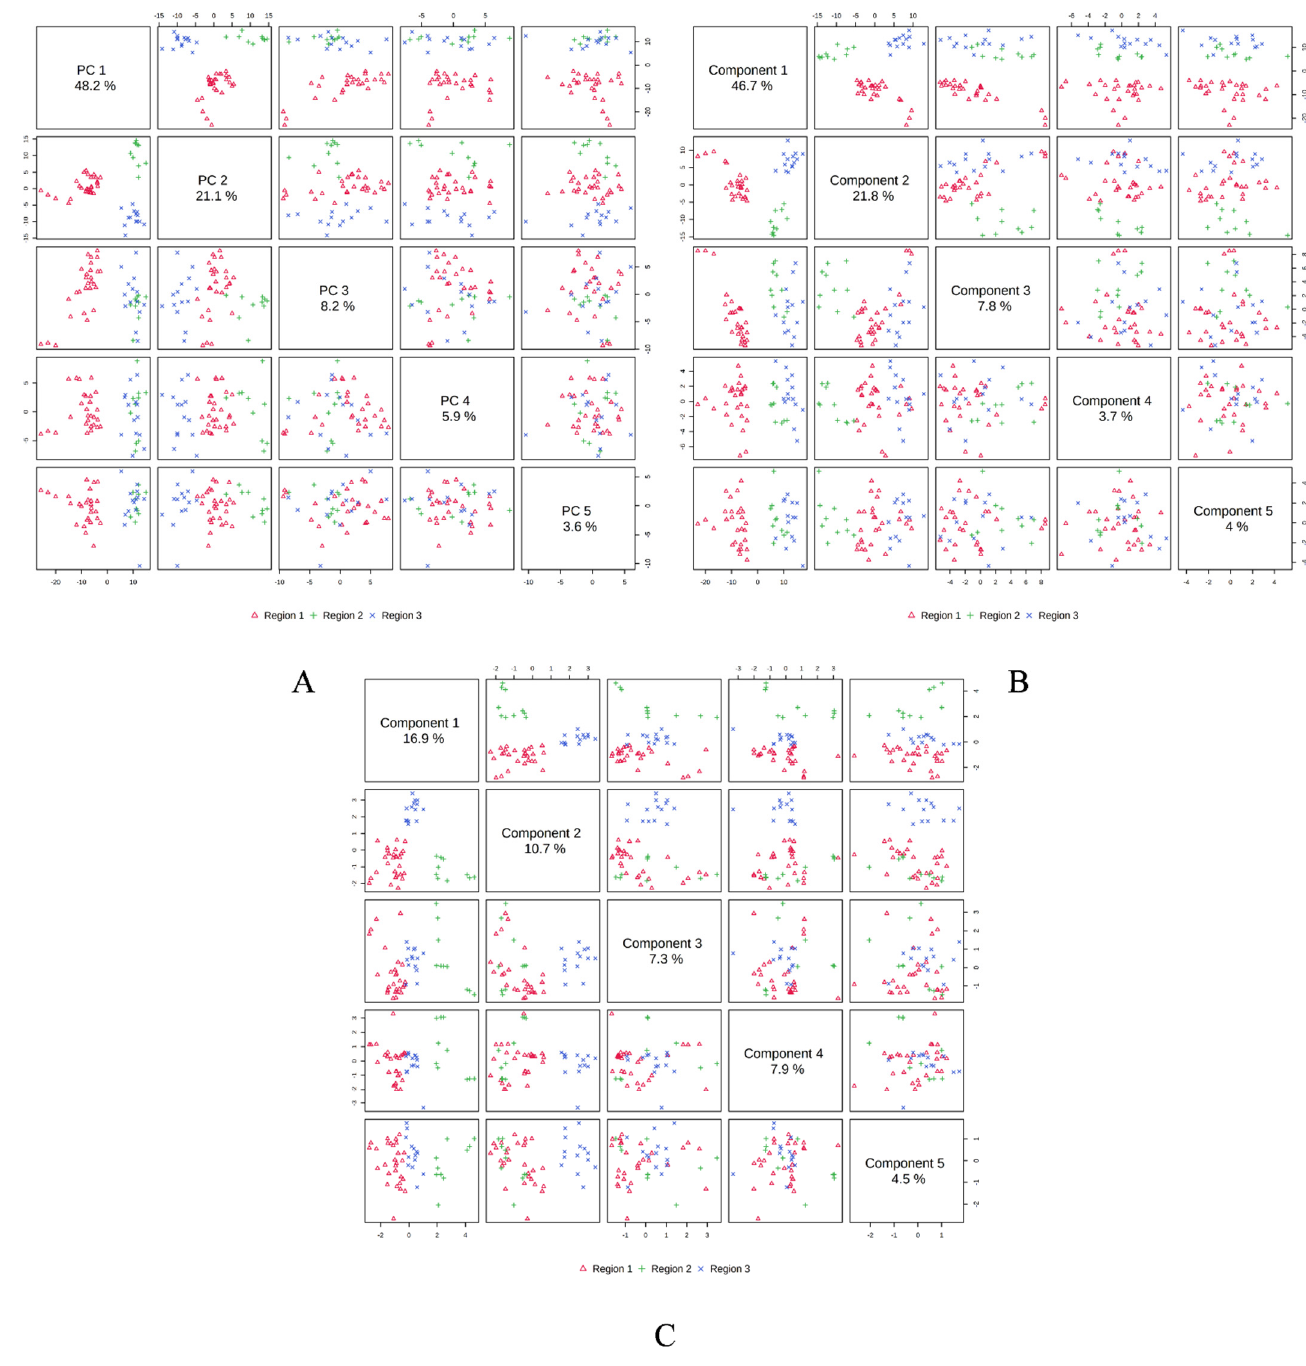
Figure 5. Pairwise score plots between the 5 selected components with their variances shown in the corresponding diagonal cell. ( A ) PCA; ( B ) PLSDA; ( C ) sPLS ‐ DA. corresponding diagonal cell. ( A ) PCA; ( B ) PLSDA; ( C )